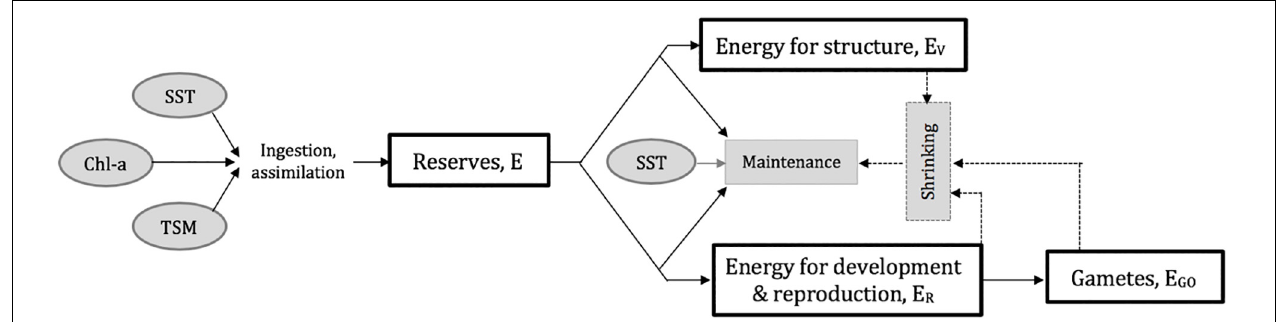
FIGURE 2 | Schematic of the Dynamic Energy Budget (DEB) modified and parameterized from Thomas et al. (2016).